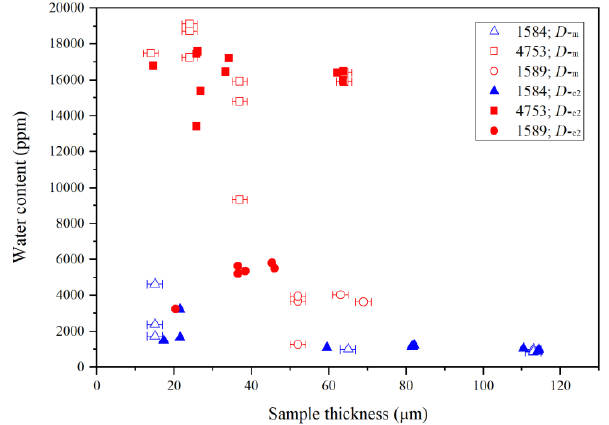
Figure 4. Water content ( C H2O ) of Mg-Rw from Run 1584, Run 1589 and Run 4753. Empty symbols represent water contents derived with measured crystal plate thickness ( D m ), whereas filled symbols represent water contents derived with calculated crystal plate thickness ( D c2 ), with the former showing more